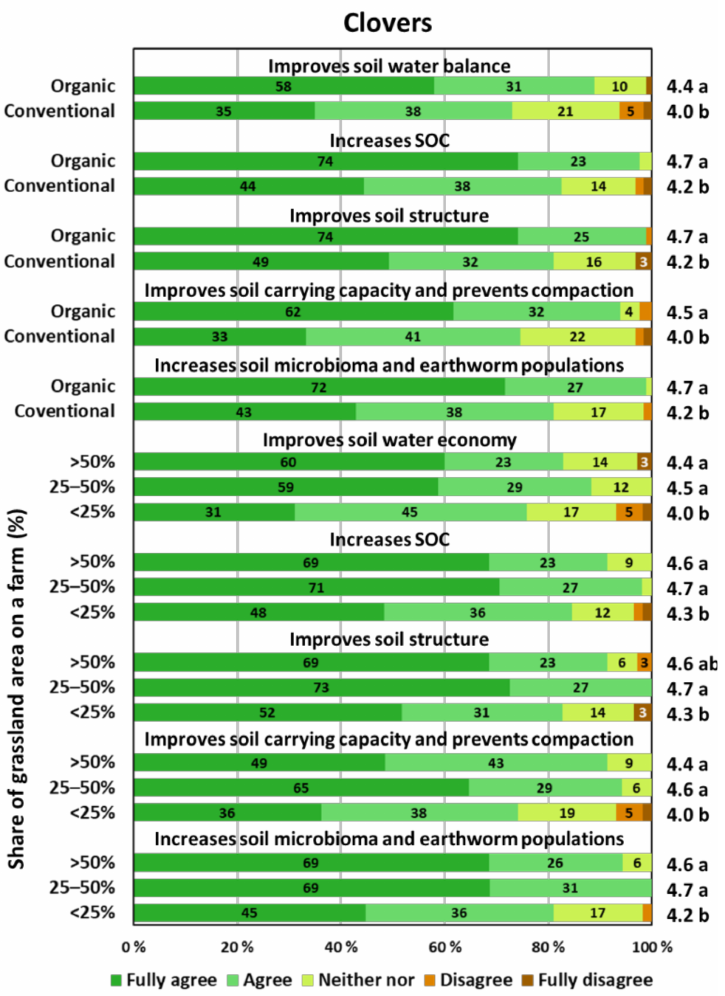
Figure 6. The distribution and mean of farmers’ experience-based answers to the statements about impact of under-sown clovers on soil health depending on farming system and the share of the cereal area on a farm. See more details in Figure